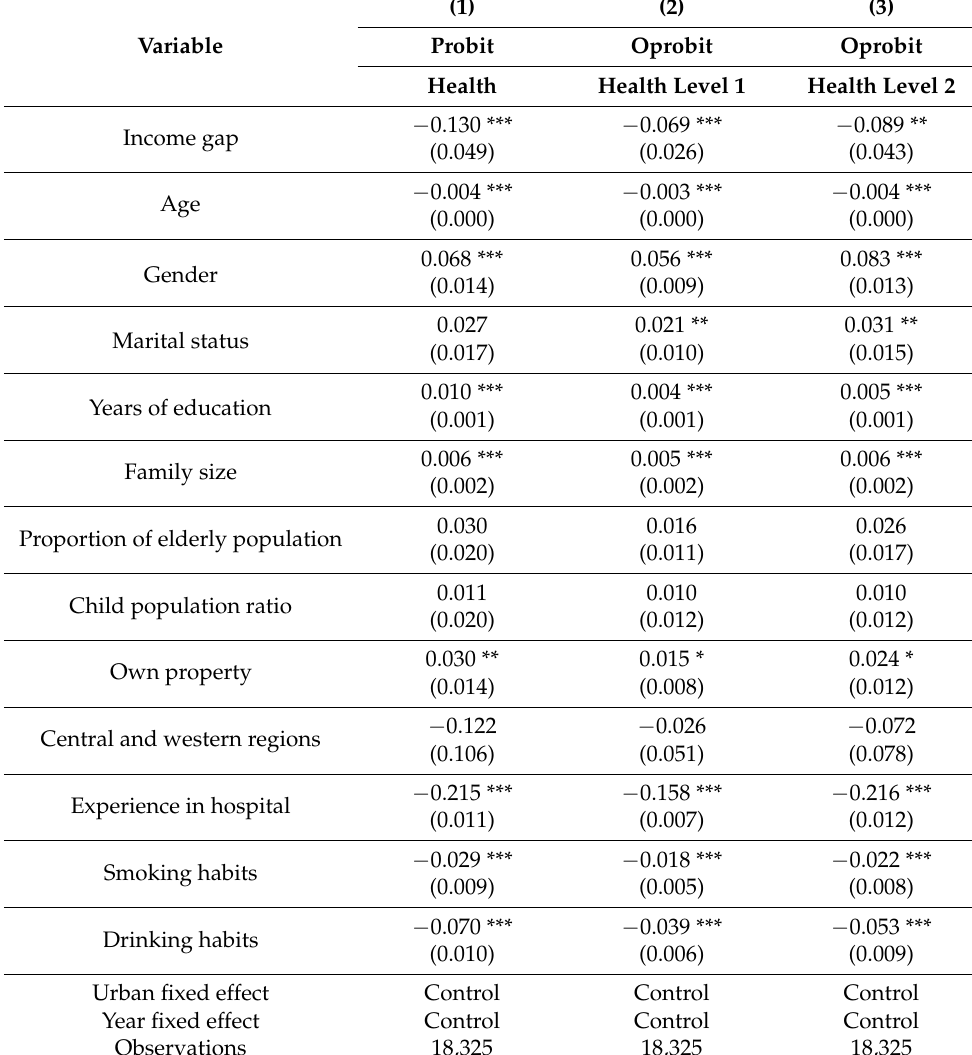
Table 7. Empirical estimation results of bidirectional fixed effects